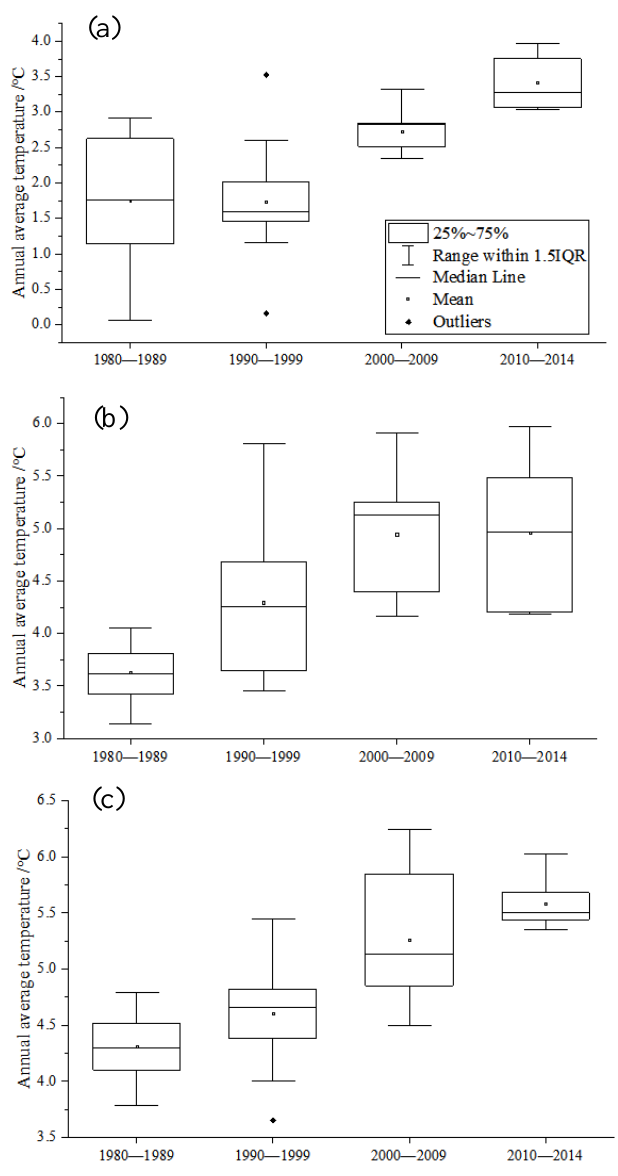
Figure 6. Annual mean temperature comparison from 1980 to 2014 ( a ): the ensemble mean of CMIP6 models with the same weights. ( b ): the annual average temperature corrected by the correction methods based on the EOF. ( c ): observed annual average temperature.